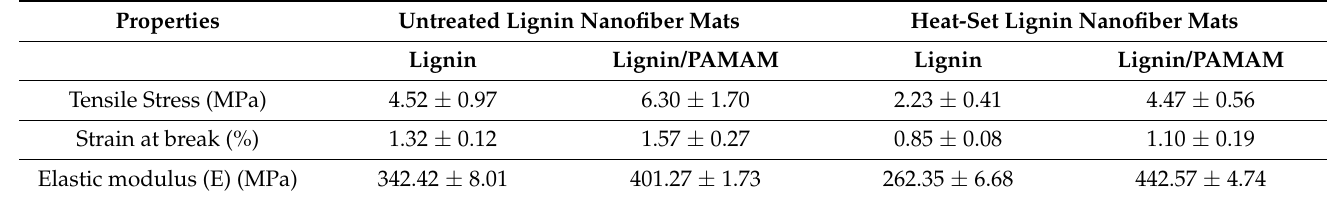
Table 2. Mechanical properties of the untreated and heat-set lignin nanofiber mats. Properties